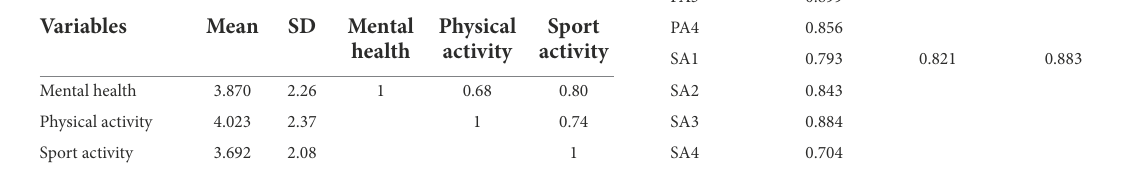
TABLE 2 Descriptive statistics and correlation among study